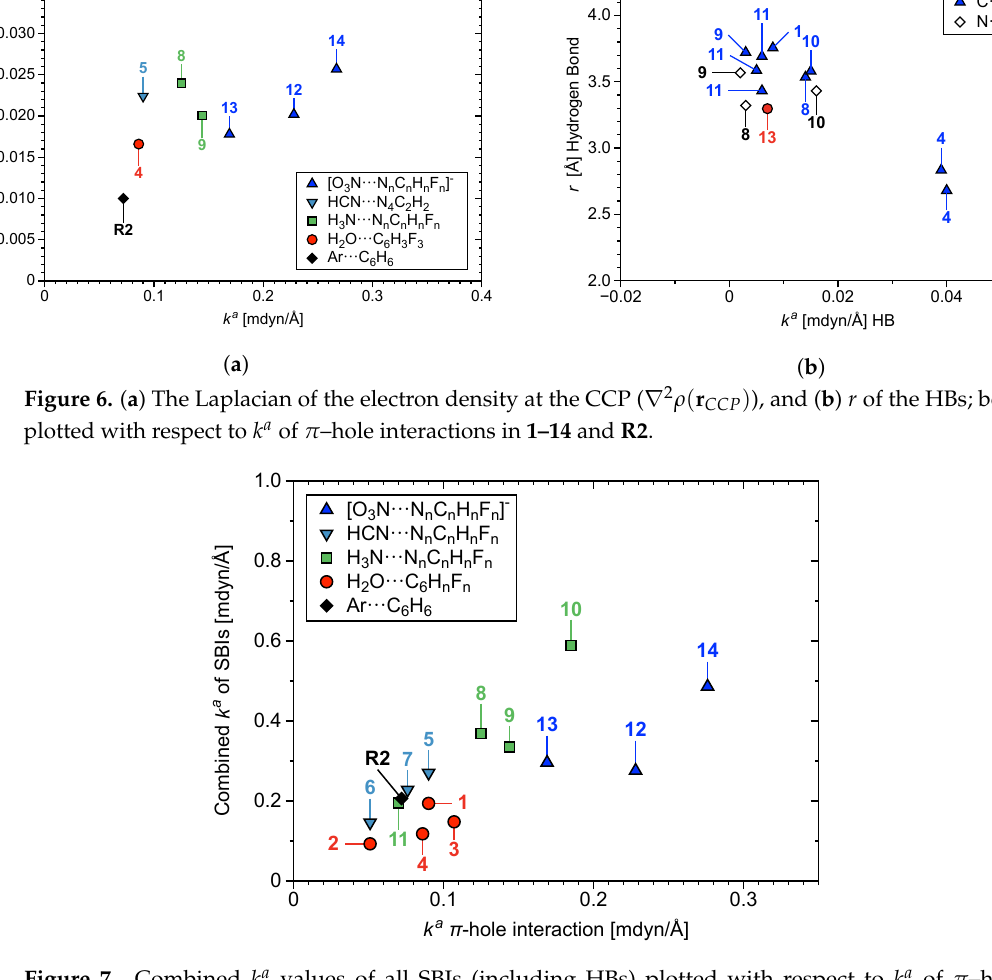
Figure 7. Combined k a values of all SBIs (including HBs) plotted with respect to k a of π –hole interactions in 1–14 and R2